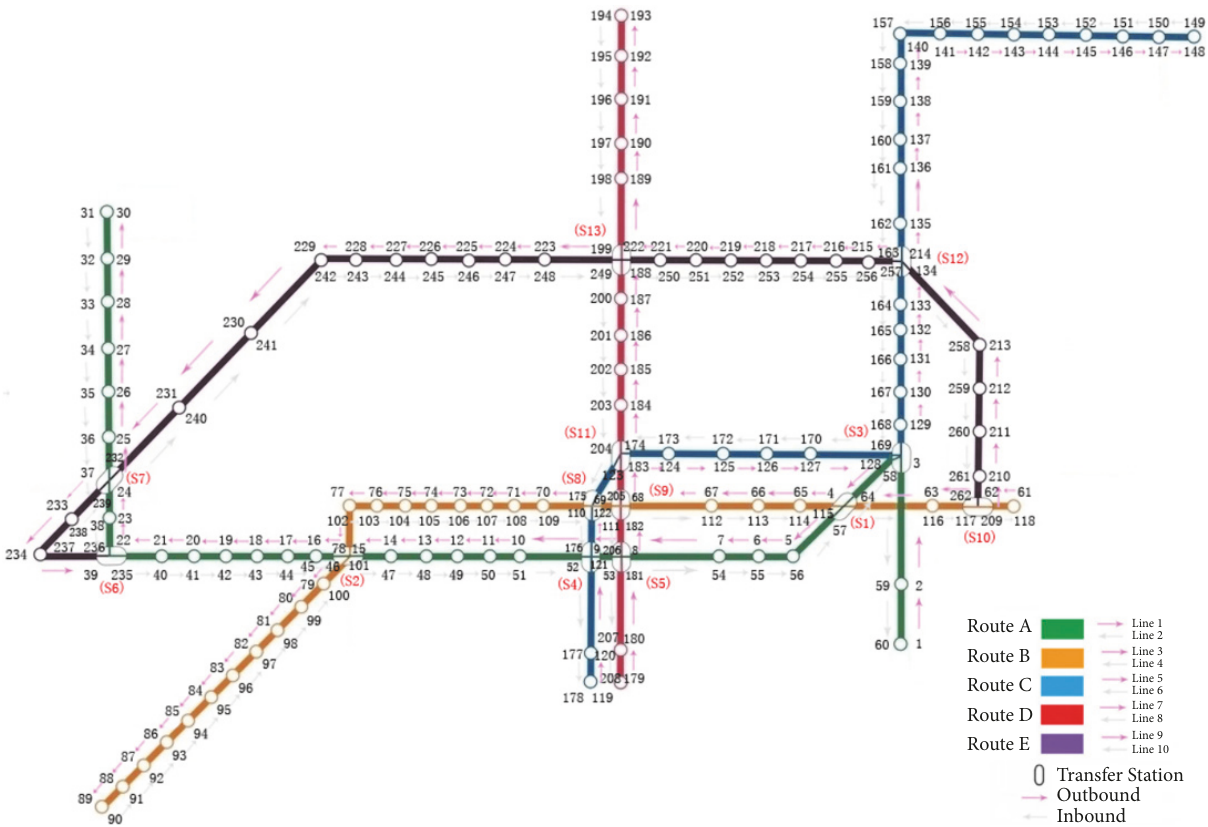
Figure 4: The studied Shenzhen metro network.